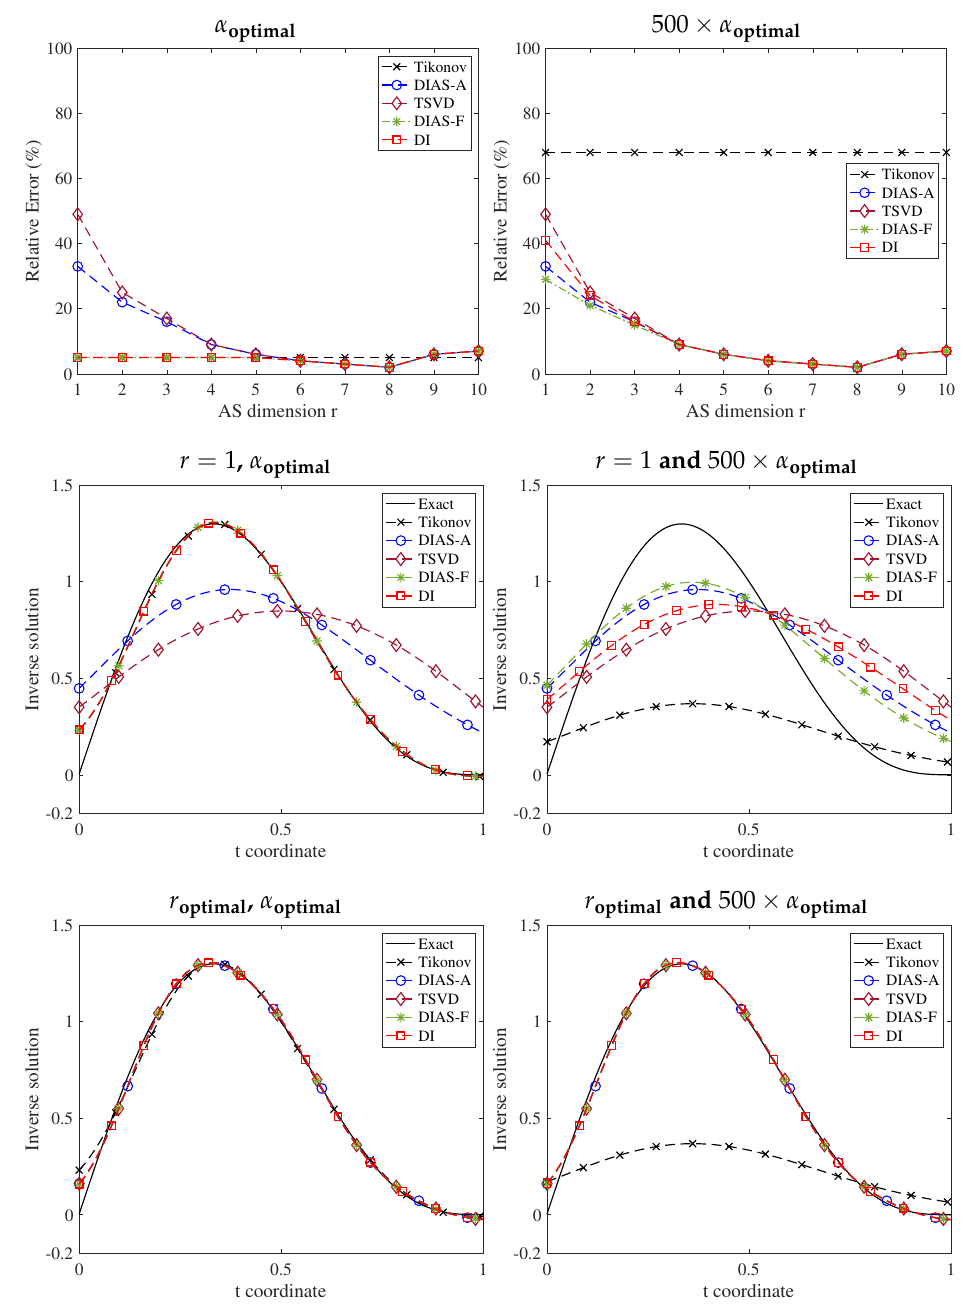
Figure 5. Gravity, α optimal = 0.138. Comparison of different DIAS regularizations and Tikhonov regularization. Top row: relative errors in the inverse solutions for different regularization methods for two values of regularization parameter. Middle row: inverse solutions with DIAS regularizations with one-dimensional active subspace and Tikhonov regularization for two values of regularization parameter. Bottom row: inverse solutions with DIAS regularizations with the optimal dimension active subspace ( r optimal = 8) and Tikhonov regularization for two values of regularization